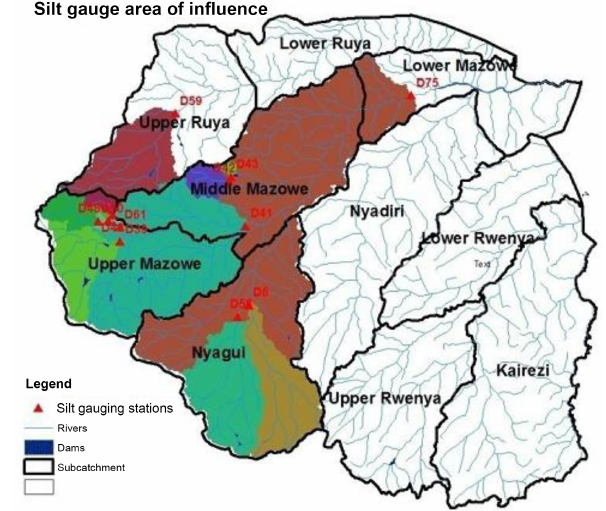
Figure 2. Gauges in the catchment and areas of